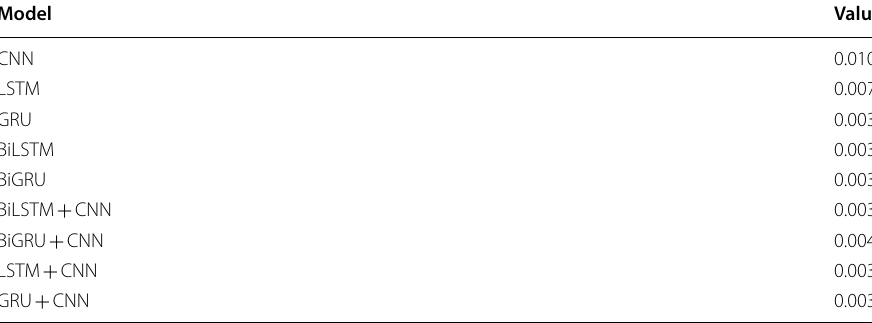
Table 8 Misclassification rate on offensive detection task